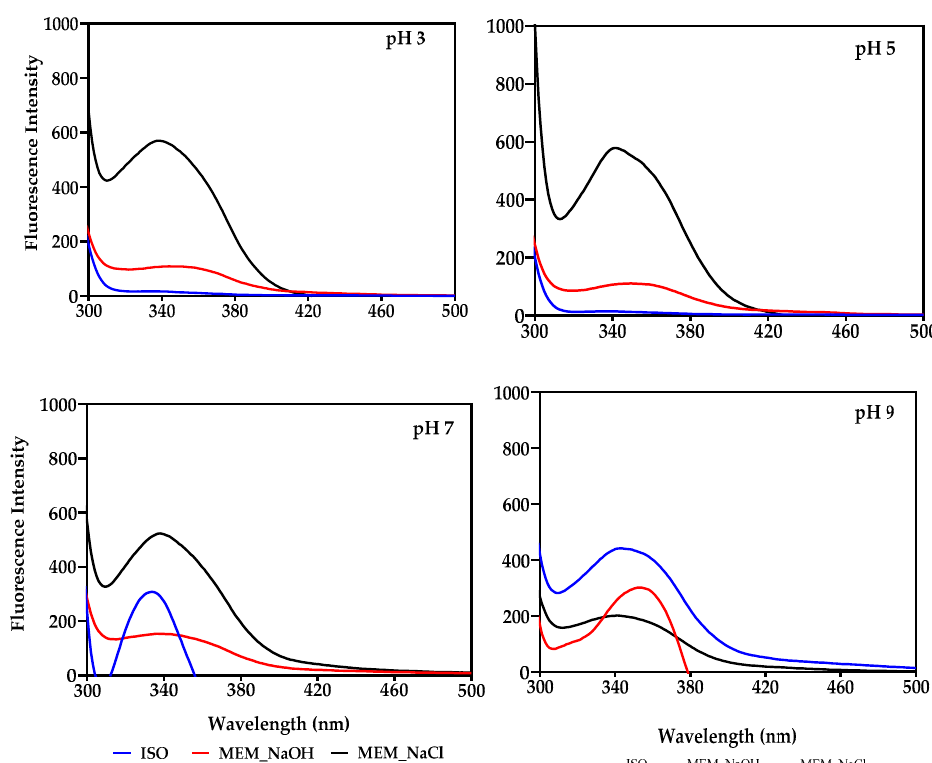
Figure 2. Intrinsic fluorescence intensity at different pH values of isoelectric pH precipitated isolate (ISO), and membrane isolated proteins from alkaline (MEM_NaOH) and salt (MEM_NaCl) solution extracts.